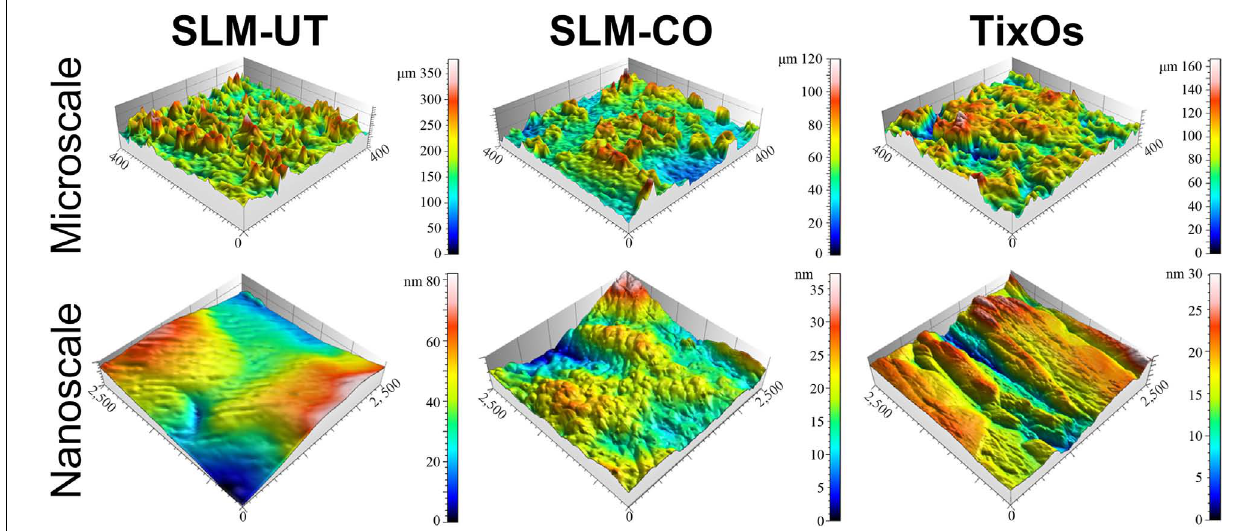
FIGURE 2 | Surface three-dimensional reconstruction view of three implants by the profilometer (at microscale) and atomic force microscope (at nanoscale).